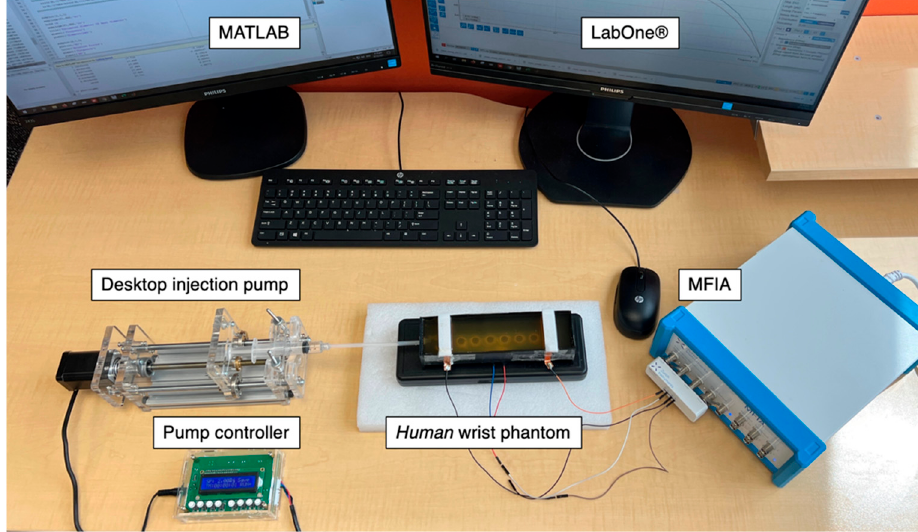
Figure 9. The entire experimental setup for the single artery model phantom ‐ pumping experiments.